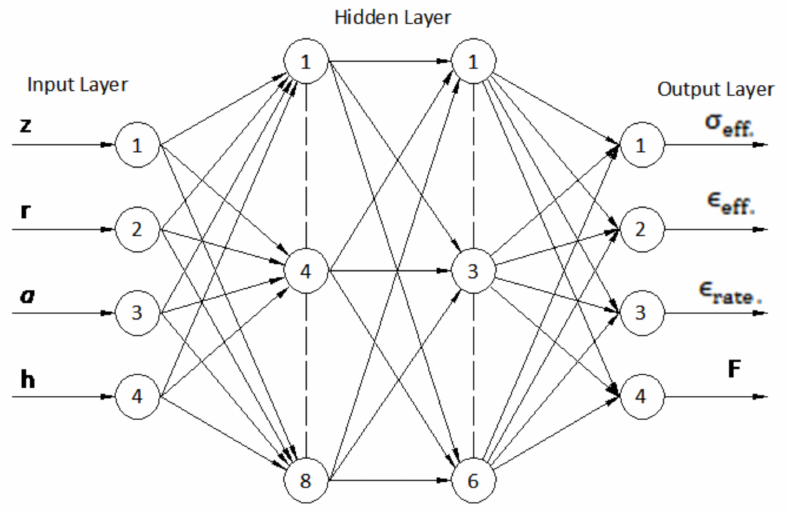
Figure 3. Multi-layer feed forward artificial neural network